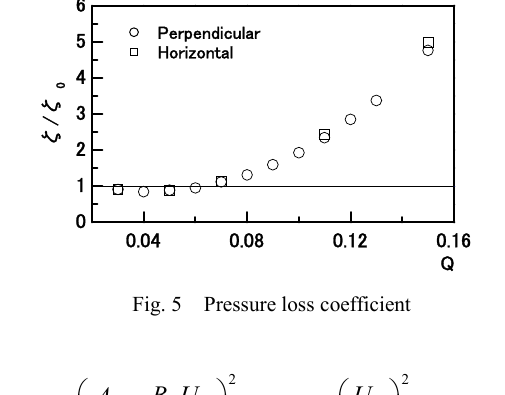
Fig. 5 Pressure loss